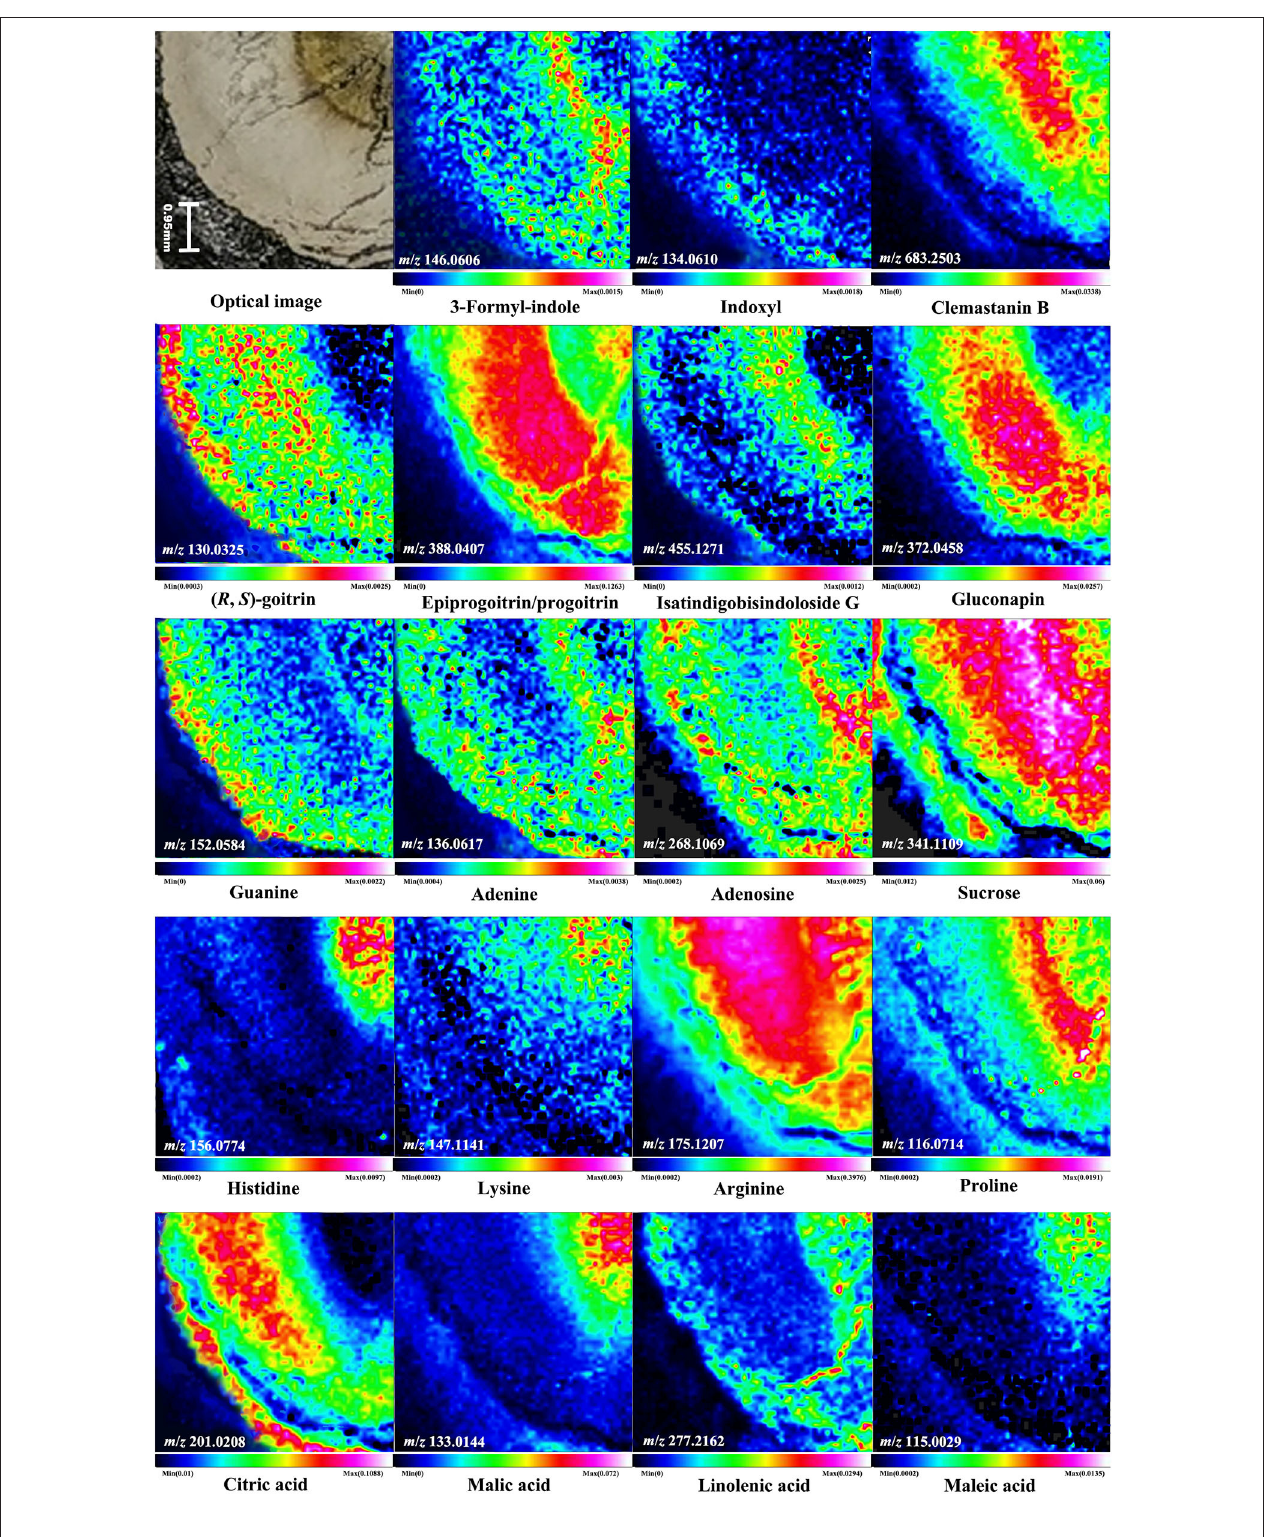
FIGURE 3 | Optical image of Isatidis Radix and the mass spectrometry images of the ions of 3-formyl-indole, indoxyl, clemastanin B, ( R , S )-goitrin, epiprogoitrin/progoitrin, isatindigobisindoloside G, gluconapin, guanine, adenine, adenosine, sucrose, histidine, lysine, arginine, proline, citric acid, malic acid, linolenic acid, and maleic acid. A color scale from white, pink, red, yellow, green, blue to blank indicates a descending absence of the signals.